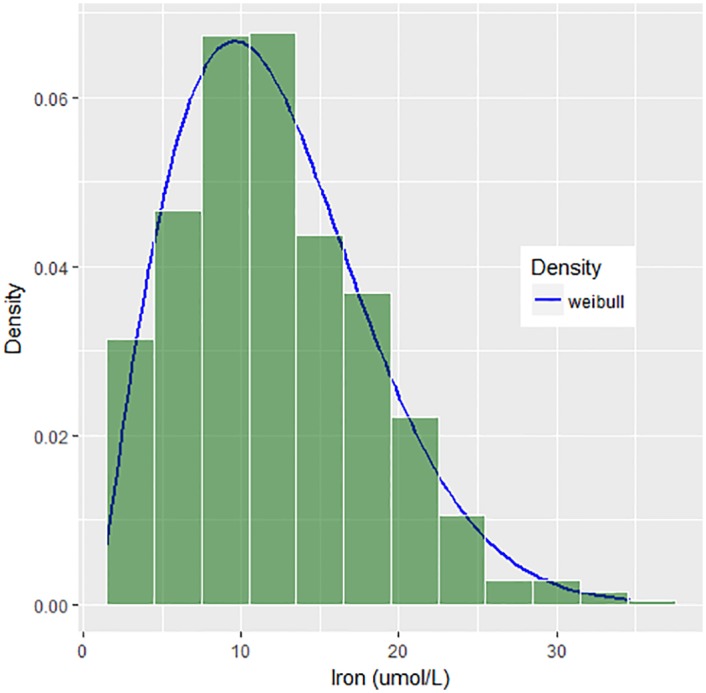
Histogram with density curve for iron.